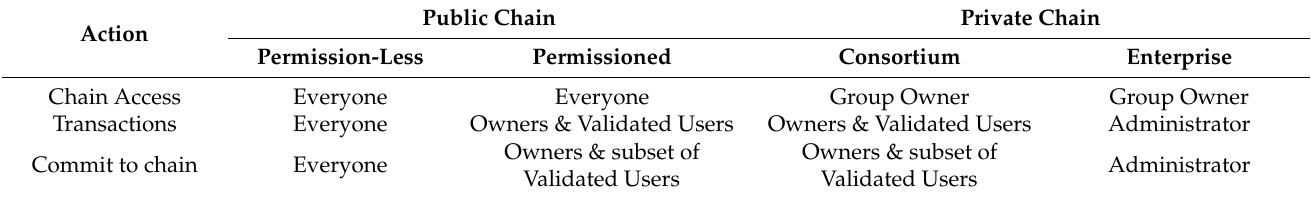
Table 5. Public vs Private Blockchain